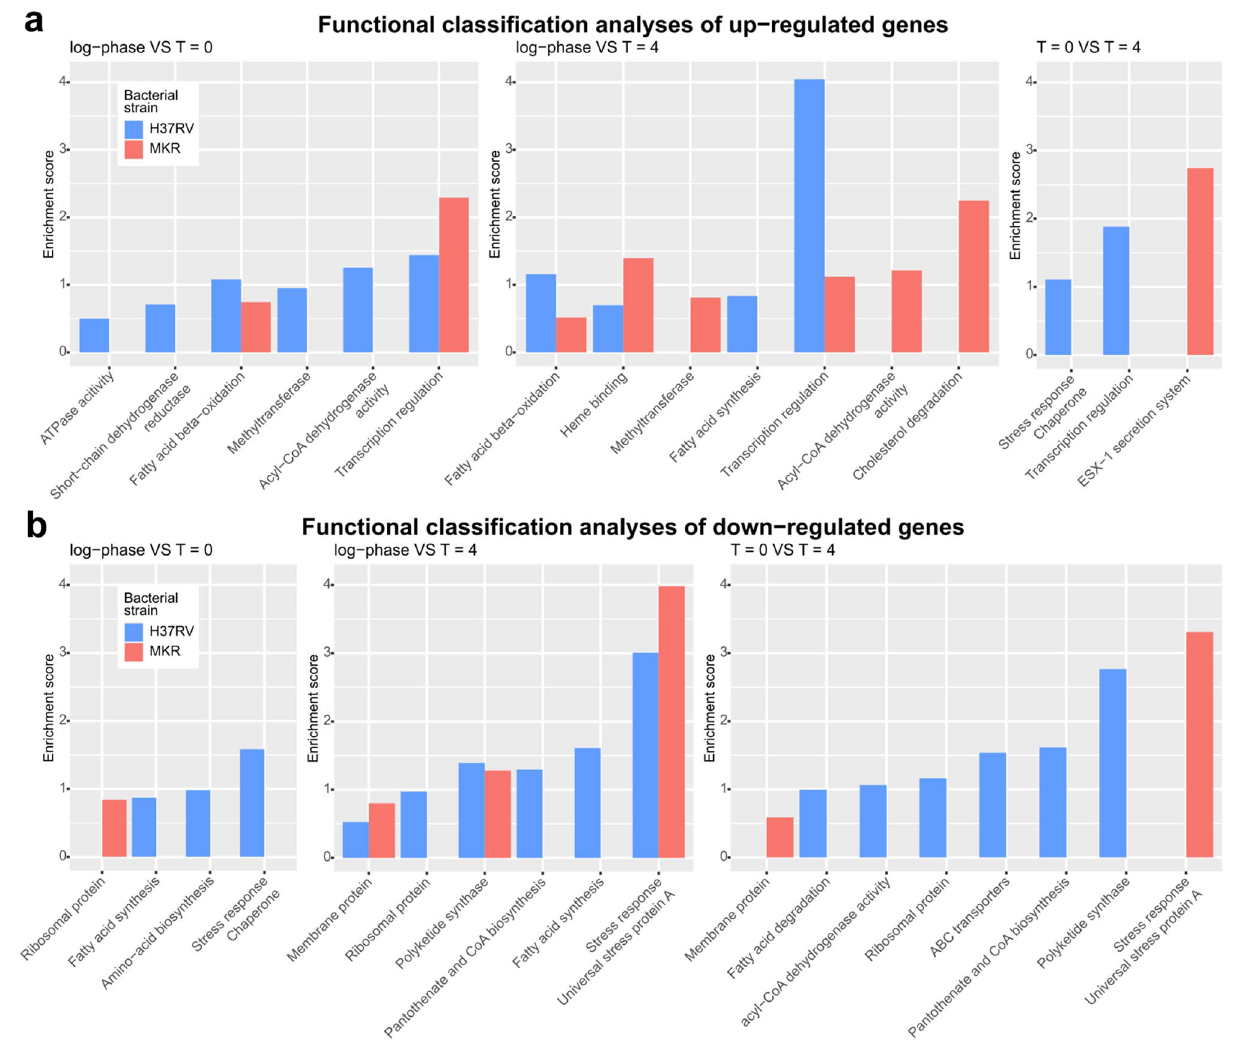
Figure 3. Gene functional classification analyses. ( a ) up-regulated genes were annotated with various functional terms, and gene functional classification analyses were performed by using DAVID Bioinformatics Resources 6.8 under the default settings. Baseline VS experimental group: log-phase VS T = 0 (left), log-phase VS T = 4 (middle), and T = 0 VS T = 4 (right). ( b ) down-regulated genes were annotated with functional terms and gene functional classification analyses were performed as in (a)